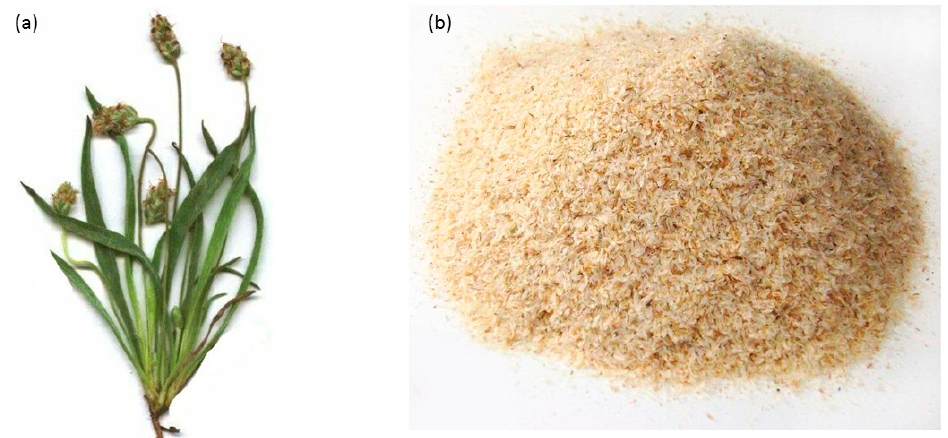
Figure 1. Plantago ovata (Forsk). ( a ) Plant; ( b ) psyllium husk powder.